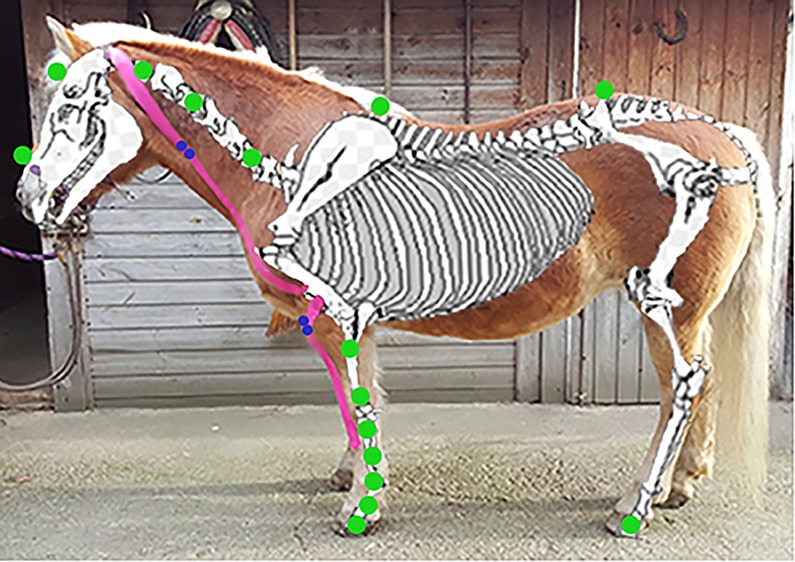
The complete marker set (green dots), the bipolar AgCl electrodes (blue dots) and the Kinesio Tapes (red stripes) on the left side of the horse’s body (lateral view).